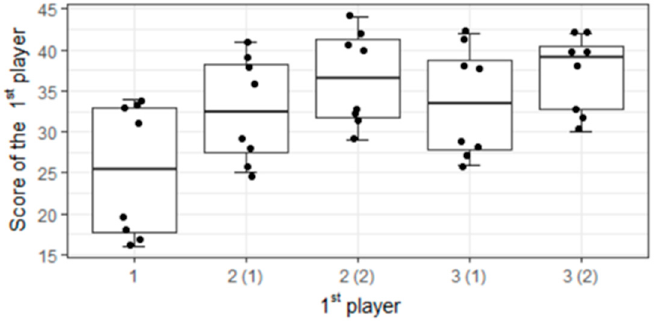
Figure 13. Box plots with jitter points for the 1st player in Table 2.